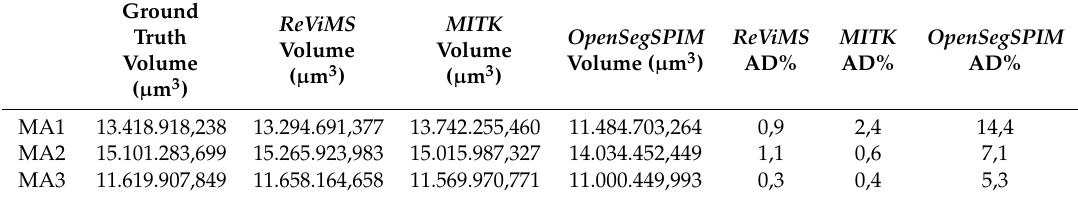
Table 2. Accuracy of MITK and OpenSegSPIM volume